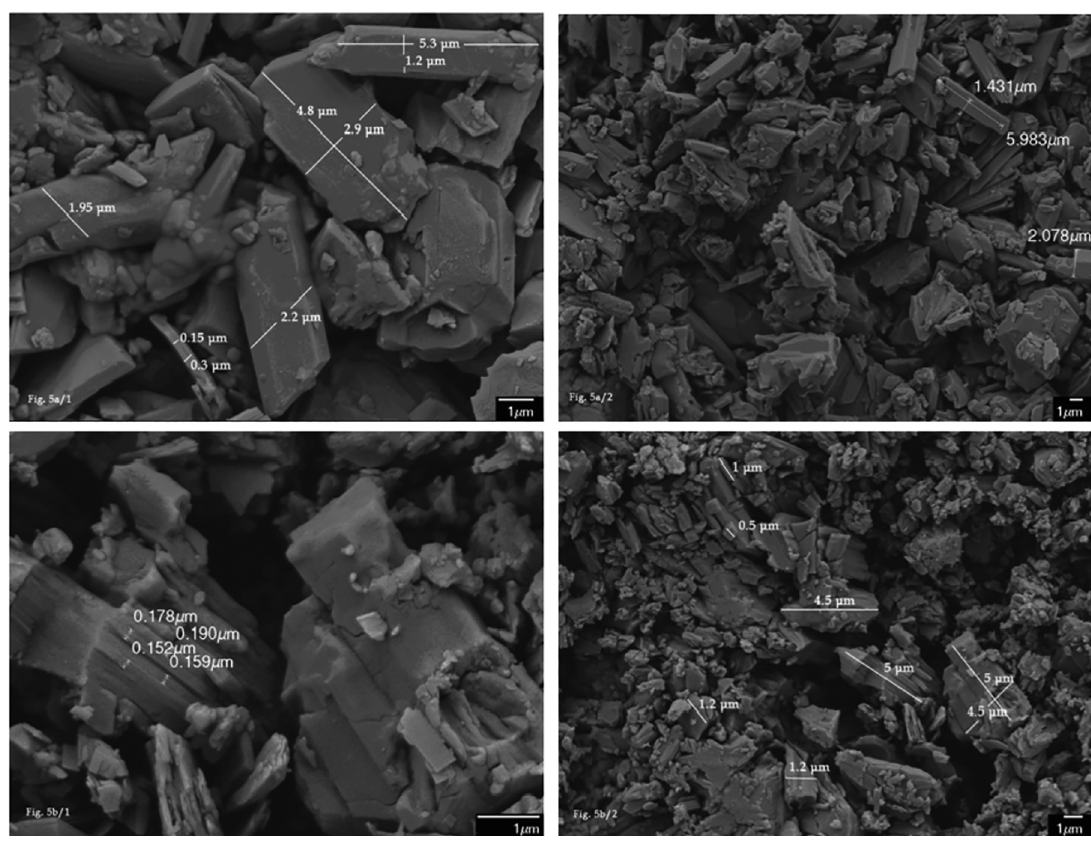
Figure 5: SEM images for CS1 sample (up) and CS2 sample (down). Table 3: Compressive and bending strength for CS1, CS2 and a PMMA